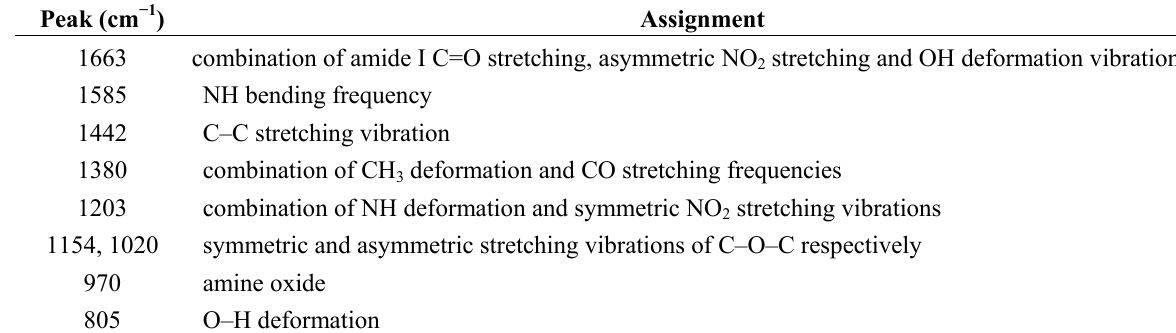
Table 1. Peak positions and assignments for the Fourier Transform Infrared spectrum of